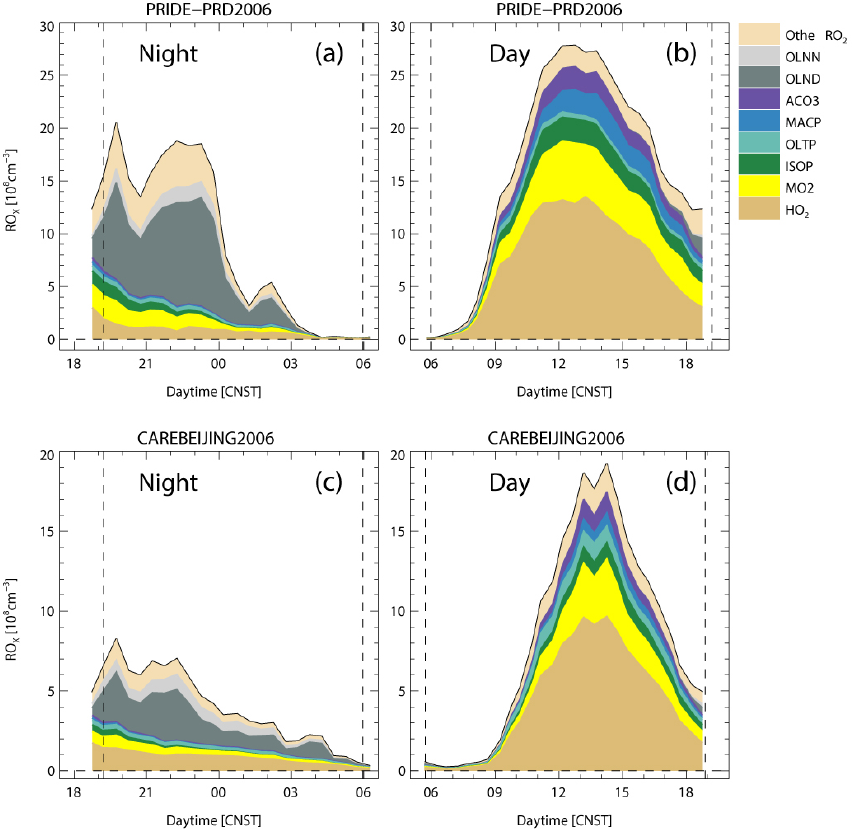
Figure 4. Modeled (M0) peroxy radical ( = RO 2 + HO 2 ) concentrations and their speciation at night (left panels) and during daytime (right